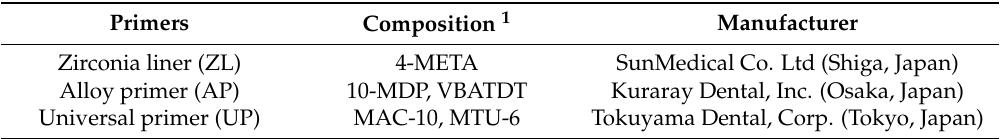
Table 1. Commercial zirconia dental